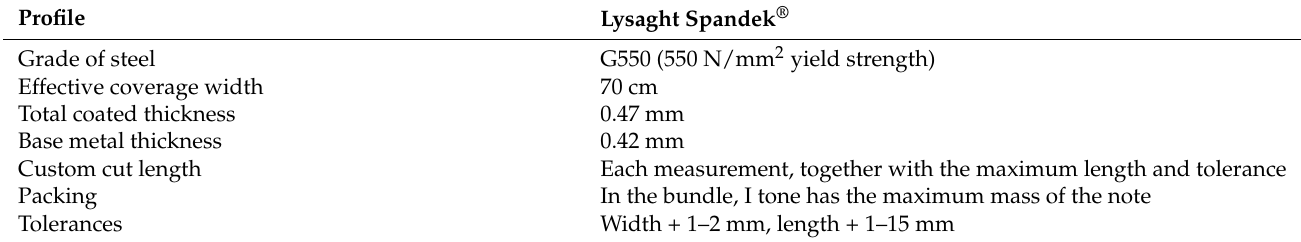
Table 1. Spandek ®